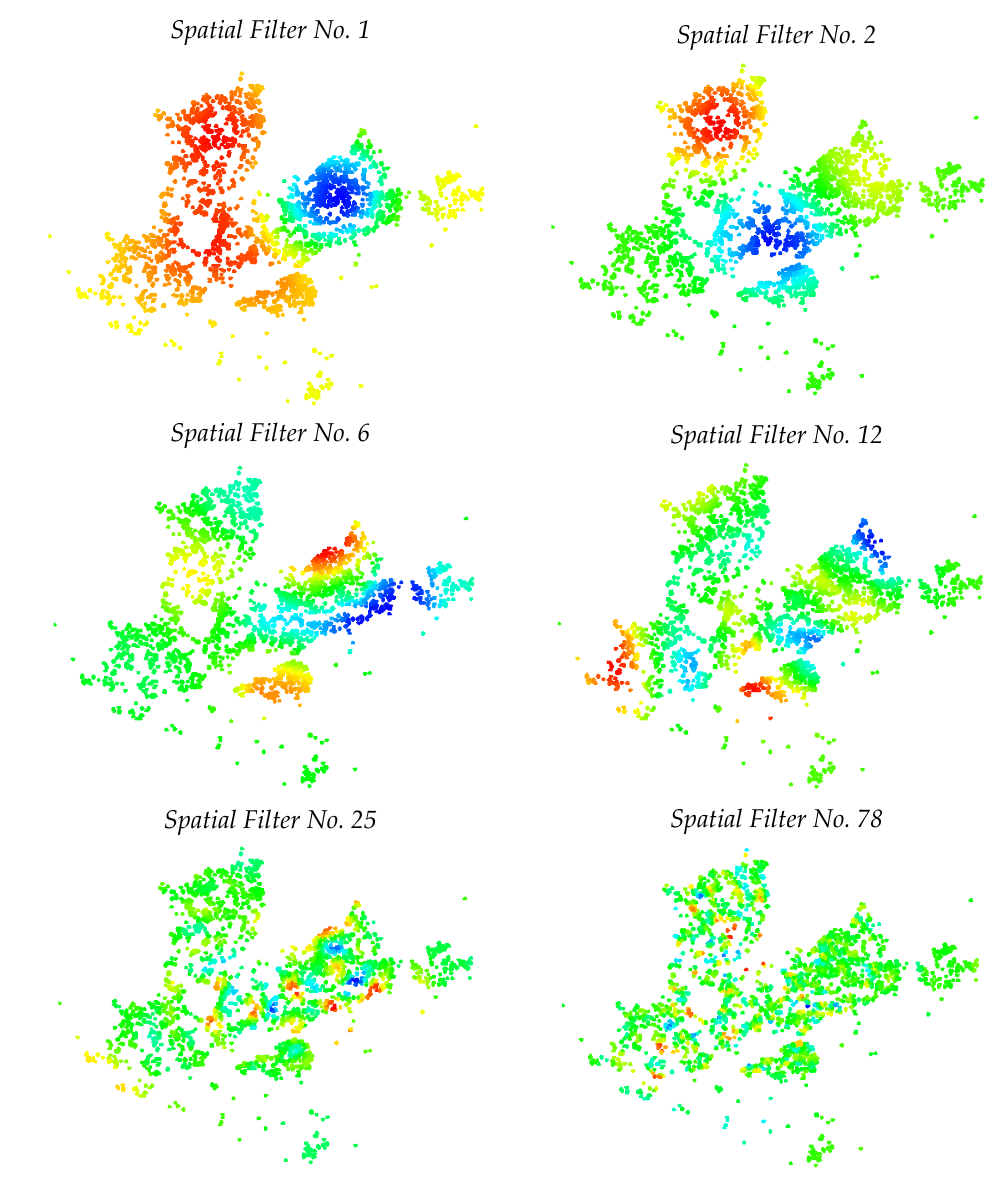
Figure 3. Spatial filters extracted across the study area geography.